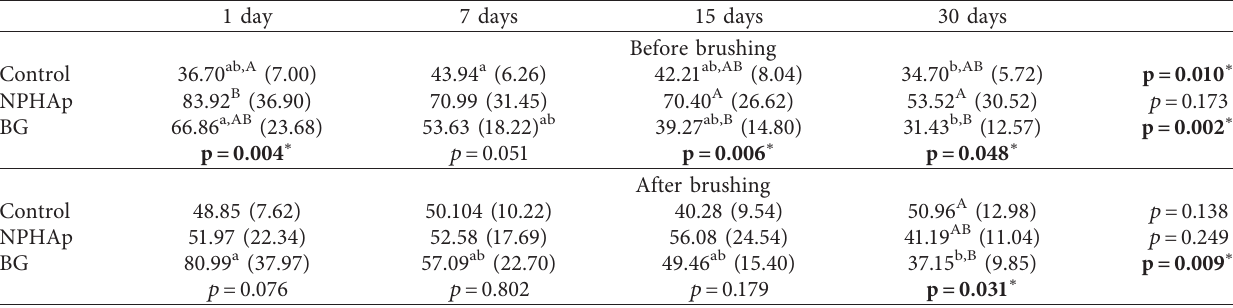
Table 5: Analysis of Vickers hardness over time, divided before and after brushing, in each group studied-means in VHN (standard deviation).